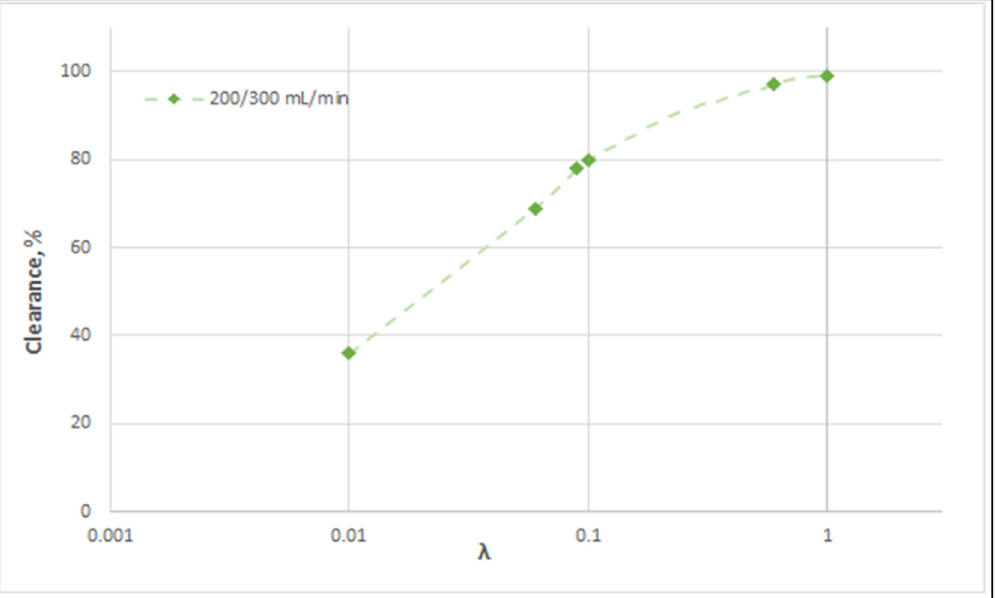
Figure 14. Effect of diffusion hindering parameter λ values on urea clearance for the tested case (I): Q Blood = 200 mL/min − Q Dialysate = 300 mL/min. For values λ → 1, the asymptotic clearance value 100% is reached.